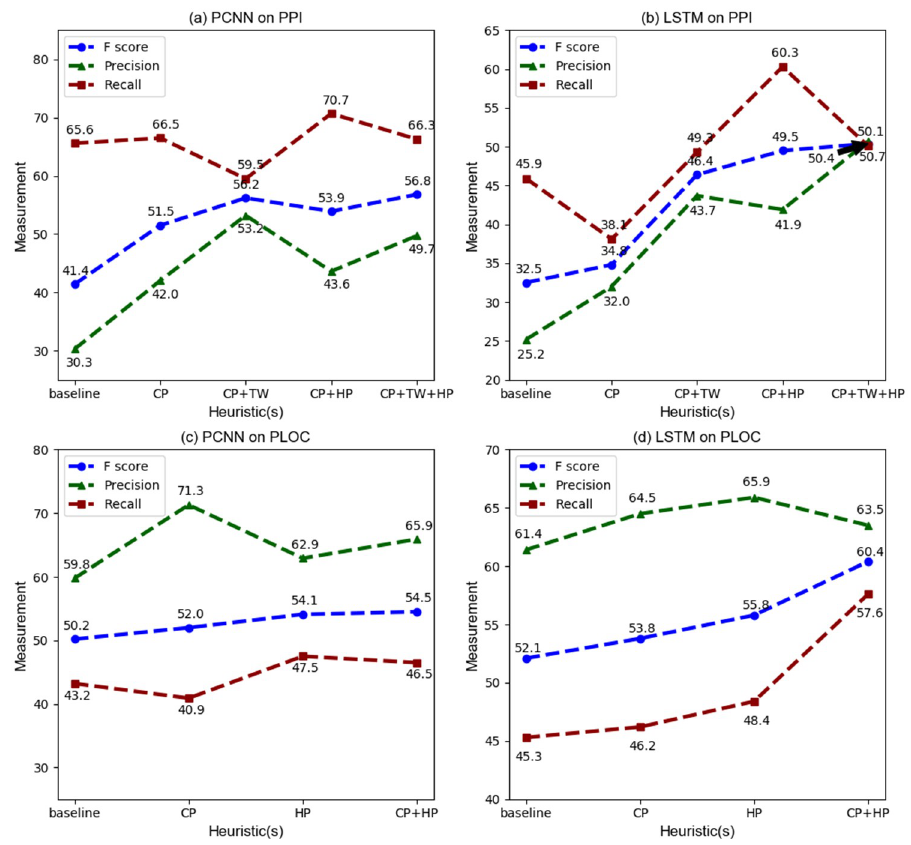
Fig 4. Performance of models built on DS